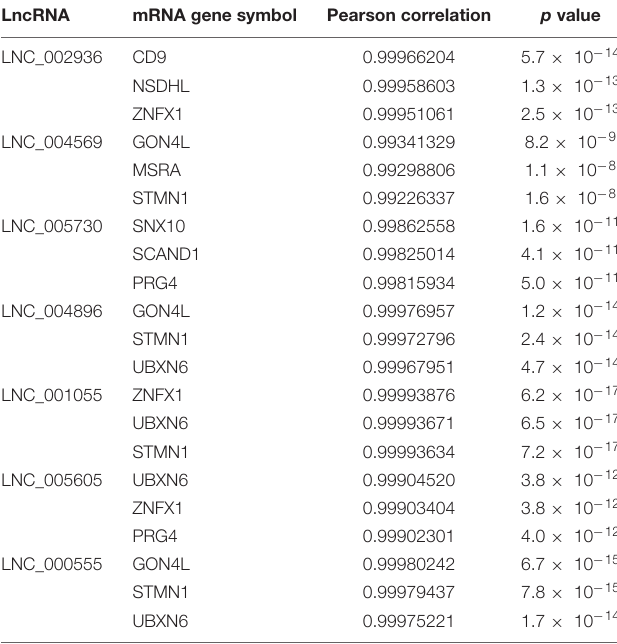
TABLE 3 | Summary of the top 3 correlated coexpressed genes of lncRNAs.